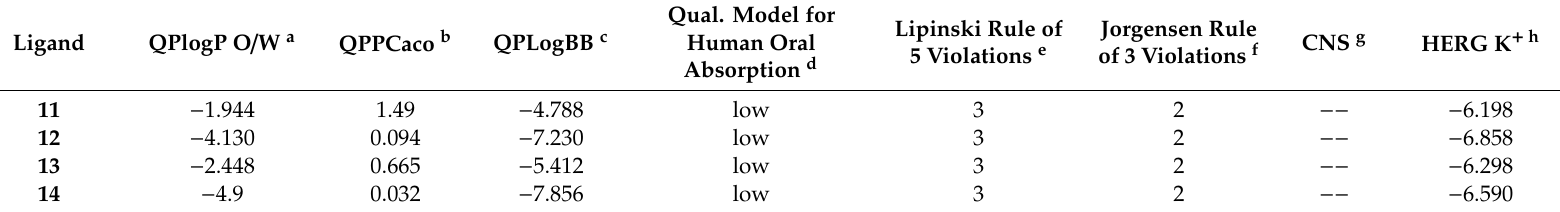
Table 6. The computed ADME parameters for the compounds 11 – 14 identified in the sea rocket ( Cakile maritima )